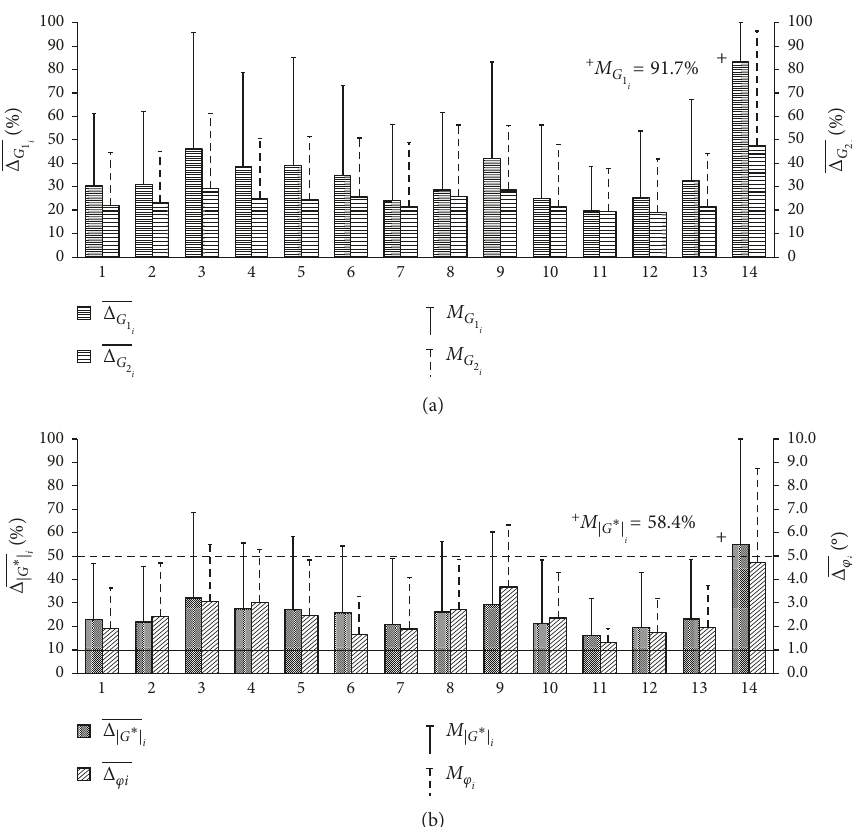
Figure 8: Histograms of global errors of 2S2P1D model fitting of all users for the bitumen (Figure 4), calculated according to equations (18)–(21): (a) relative errors for G are plotted according to standard deviations M